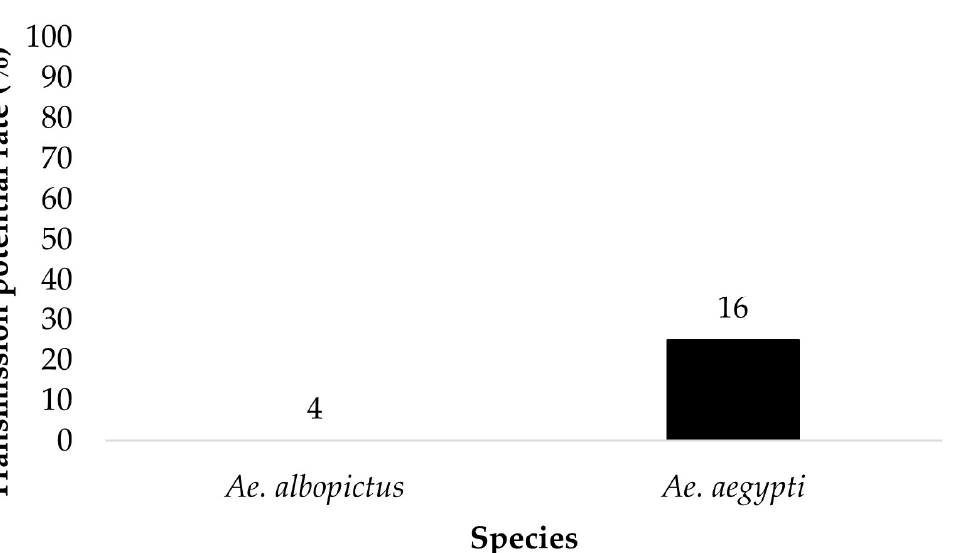
Figure 6. Transmission potential (saliva infection) of parental Ae. aegypti and Ae. albopictus for treatment groups ingesting infected blood at a dose of 7 log 10 PFU/mL ZIKV infectious bloodmeal. Numbers above the bars represent the number of mosquitoes tested.